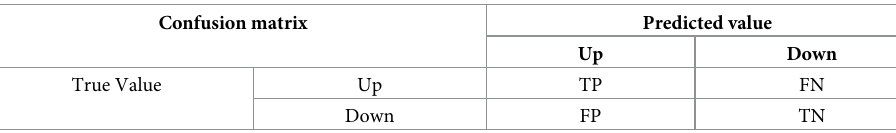
Table 4. Confusion